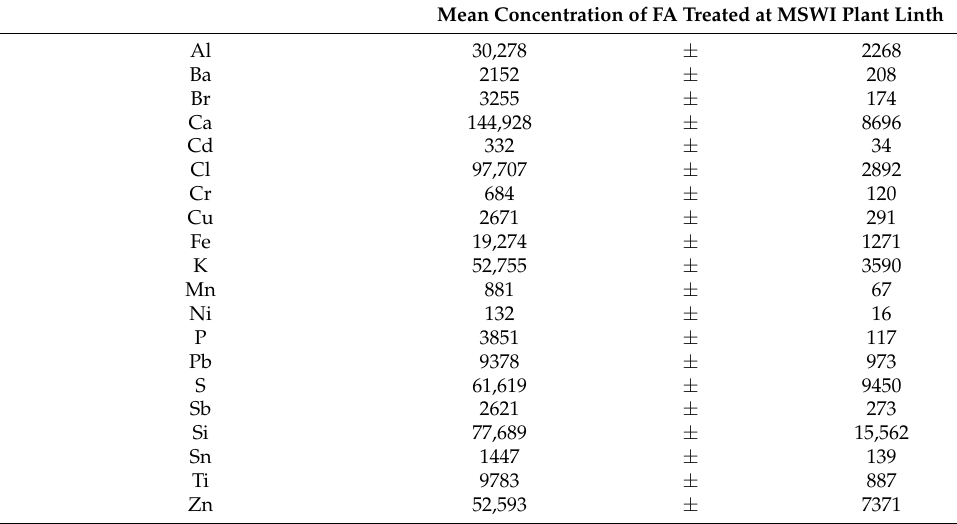
Table 1. Mean elemental composition in mg/kg and standard deviation of the fly ash (FA) treated at municipal solid waste incineration (MSWI) plant